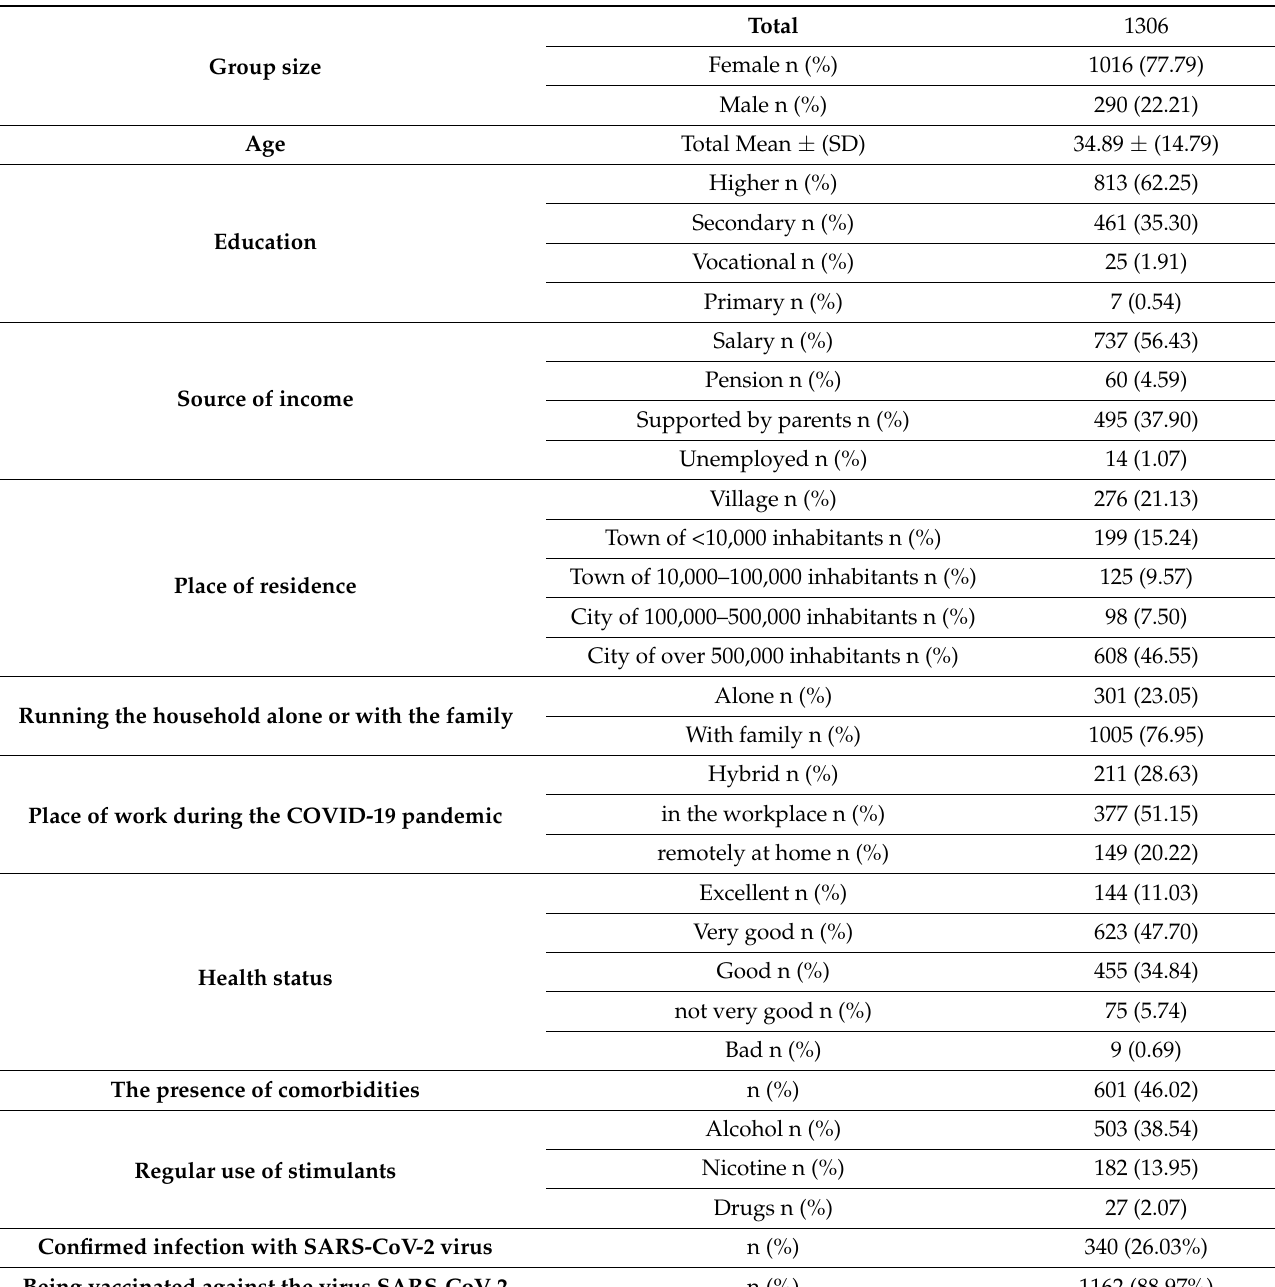
Table 1. General characteristics of patients (n = 1306).